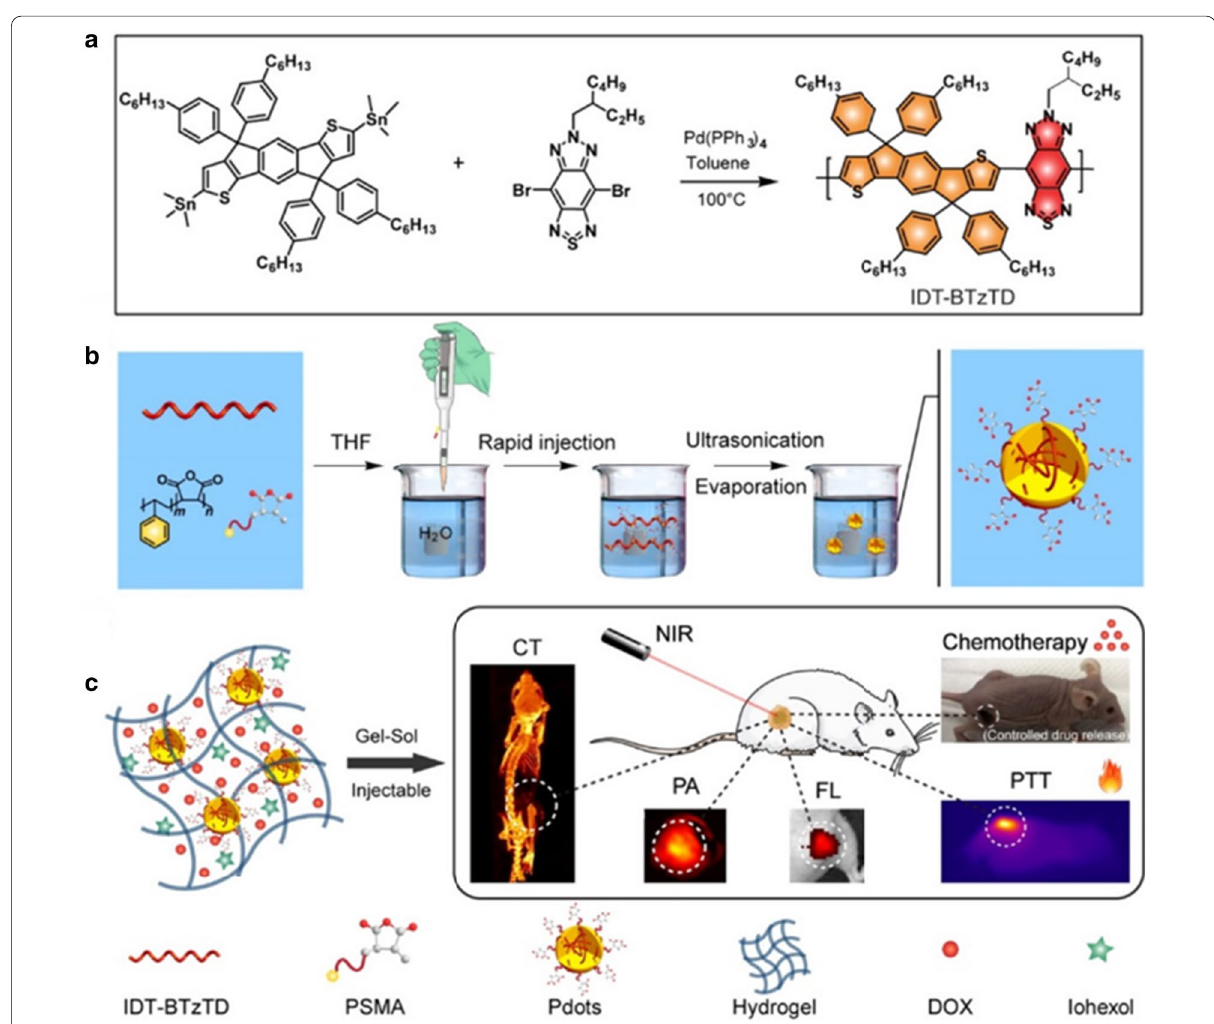
Fig. 2 a Schematic of the fabrication of conjugated polymer IDT Pdots DOX iohexol@hydrogel for trimodal FL/PA/CT imaging-guided synergistic chemo-photothermal cancer therapy [36]. Copyright 2020 ACS − − Appl. Mater.